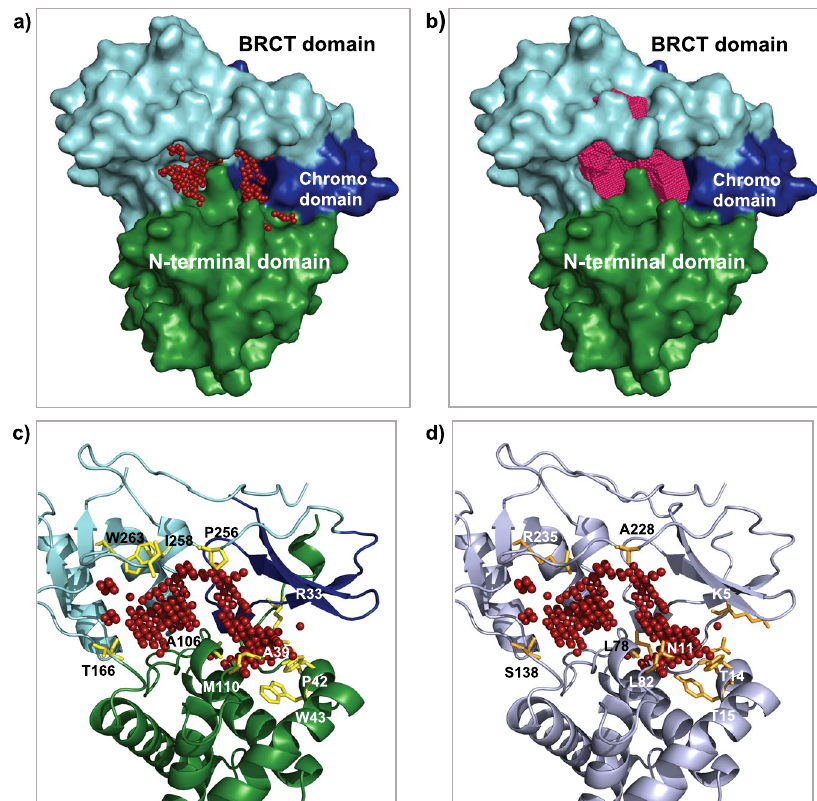
Fig. 4 Computationally identi fi ed small-molecule-binding pockets as potential druggable sites. a Surface representation of the X-ray crystal structure of the N-terminal module of BF155 with the red dots indicating the binding site identi fi ed by SiteMap. b Binding site identi fi ed by DoGSite Scorer highlighted in pink. c Cartoon representation of the structure with the red dots indicating the binding site identi fi ed by SiteMap: the residues of the pocket on BAF155 that differs from BAF170 are labelled and highlighted in yellow (stick representation). d Highlighted in orange are the labelled residues (stick representation) on the carton representation of the homology model of BAF170 that differs from (Fig. 4a, b): SiteMap DScore of 0.98 and DoGSiteScorer Drug Score of 0.81.